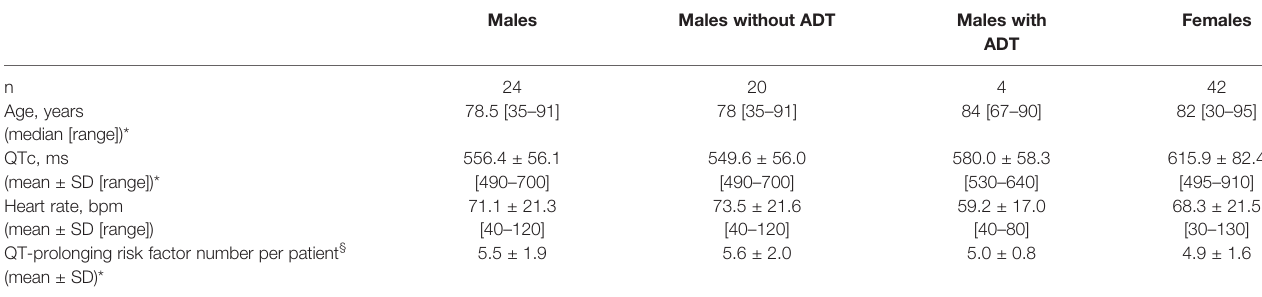
TABLE 2 | Demography, QTc and QT-prolonging risk factors in patients with TdP: comparisons by sex and androgen deprivation therapy (ADT). Males